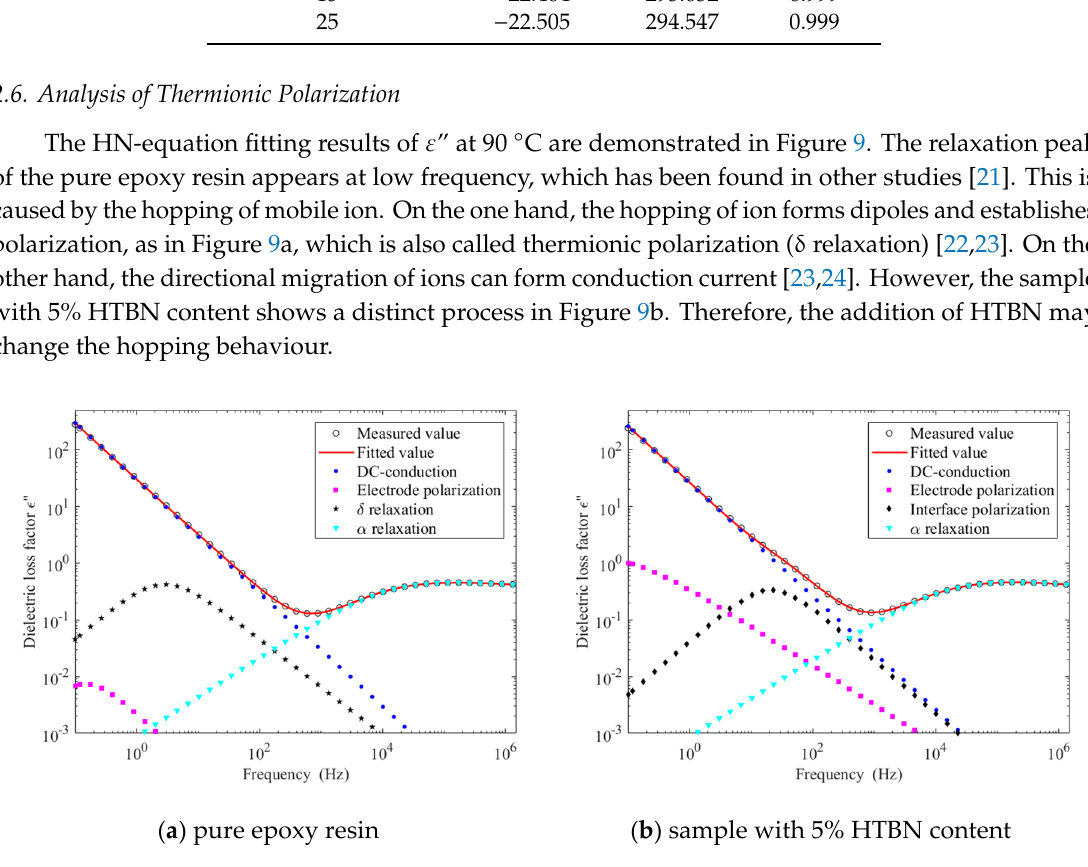
Figure 9. HN-equation fitting results of dielectric loss factor of pure epoxy resin and sample with 5% HTBN content at 90 °C: ( a ) pure epoxy resin; ( b ) sample with 5% HTBN content.